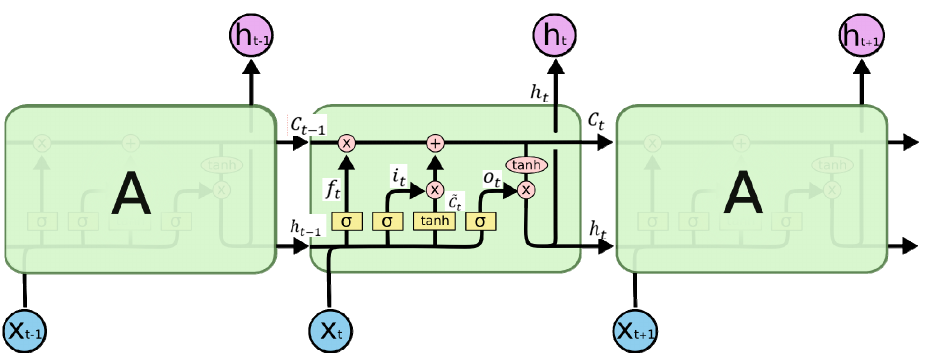
Figure A1. The repeating module in an LSTM contains four interacting layers. Cell state is the key of LSTM. In order to protect and control the state of memory unit, three control gates are placed in a memory unit, which are called input gate, forgetting gate, and output gate, respectively. Each control gate consists of a NN layer containing a sigmoid function and a point multiplication operation. The structure diagram of LSTM memory unit is shown in the figure below. In the figure, a horizontal line running through the top of the schematic diagram from the input on the left to the output on the right is the state of the memory unit. The NN layers of forgetting gate, input gate, and output gate are represented by layers, and the output results are represented by x 1 , x 2 , and x 3 , respectively. The two layers in the figure correspond to the input and output of the memory unit respectively. The first layer generates a vector to update the cell state. LSTM also relies on back propagation to update parameters. The key to iteratively updating the required parameters through the gradient descent method is to calculate the partial derivatives of all parameters based on the loss function. There are two hidden states in LSTM, which are h t and C t .